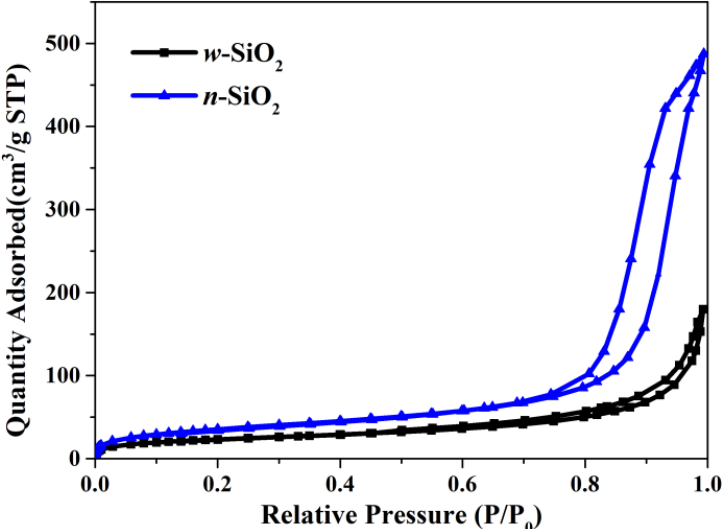
Figure 2. Adsorption and desorption isotherms of nitrogen on w -SiO 2 and n -SiO 2 samples.